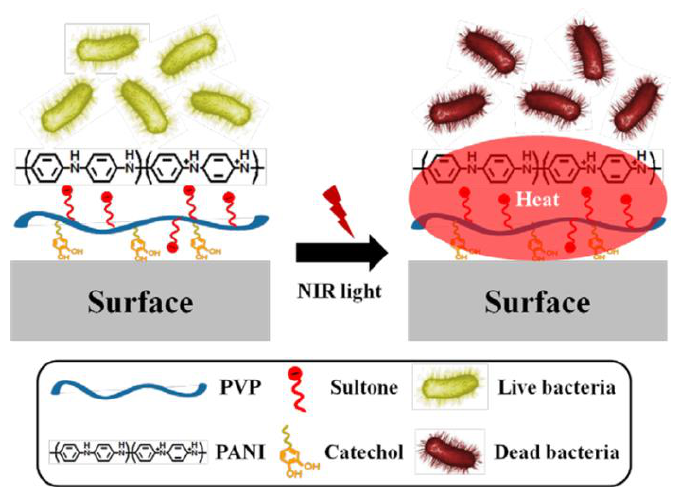
Figure 6. Schematic illustration for the preparation and application of PVPS:PANI coating and NIR irradiation for the photothermolysis of bacteria (images are reproduced from [94] with the copyright permission from American Chemical Society).